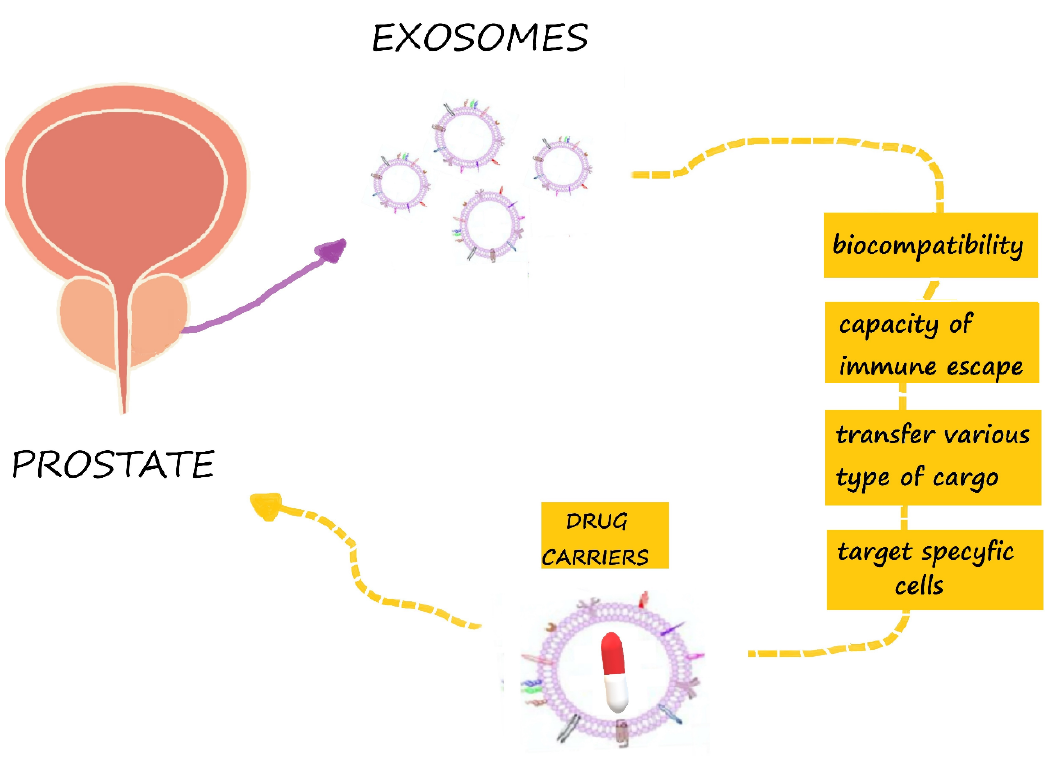
Figure 3. Exosomes are promising drug carriers in prostate cancer therapy.